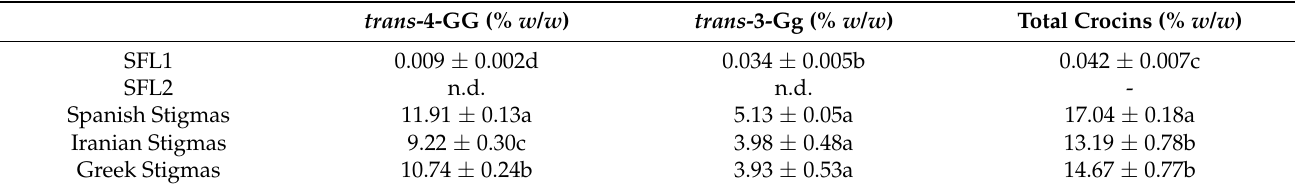
Table 2. Crocins in saffron floral by-products and saffron stigmas 1 . trans -4-GG (% w / w